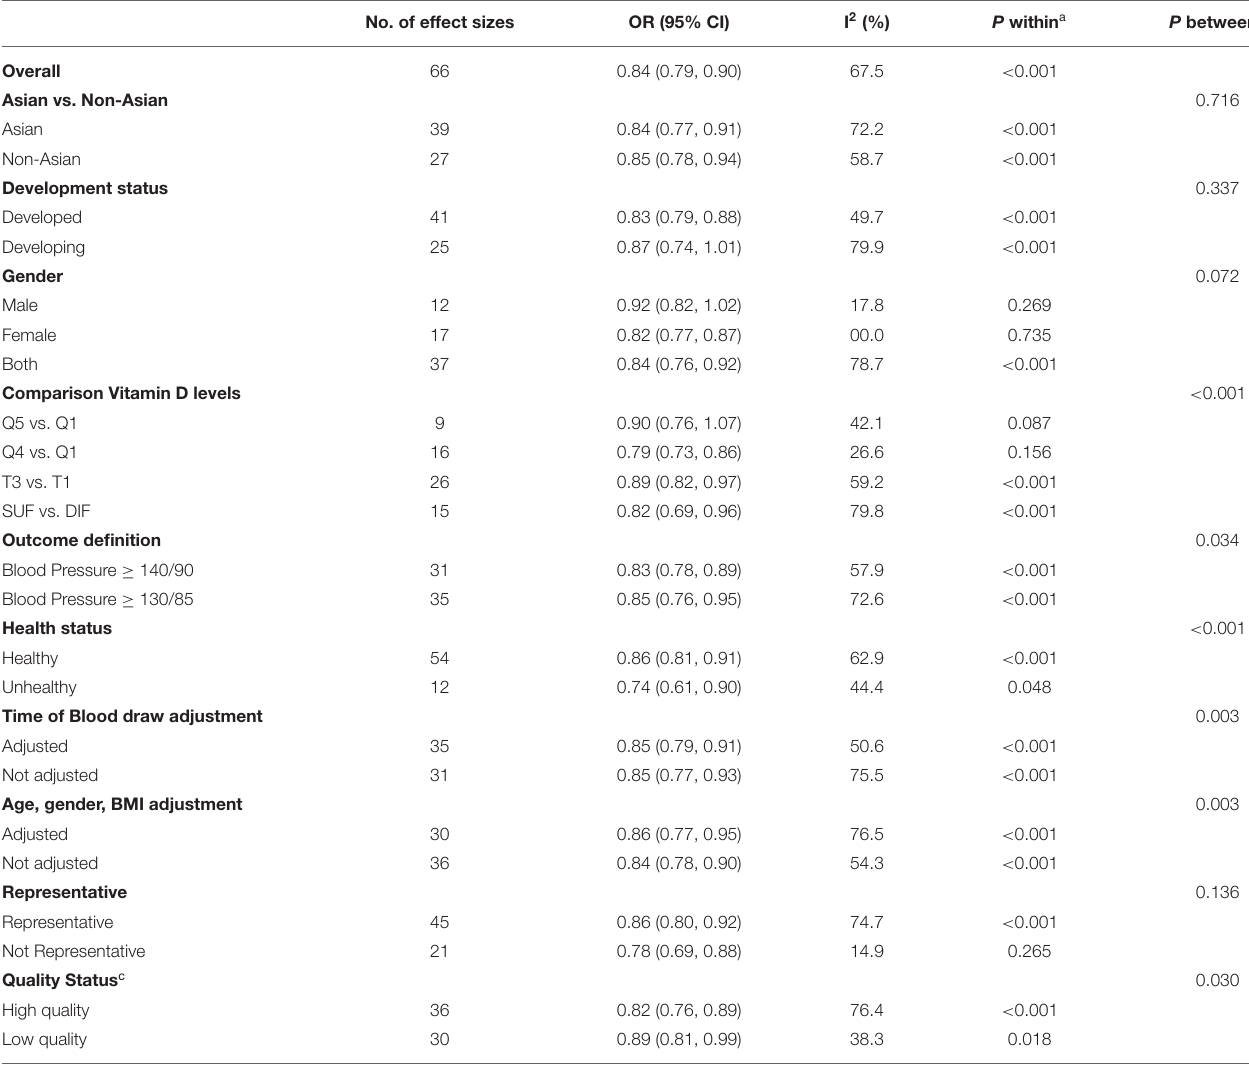
TABLE 3 | Results of subgroup-analysis for circulating vitamin D levels and odds of hypertension in cross-sectional studies. No. of effect sizes OR (95%